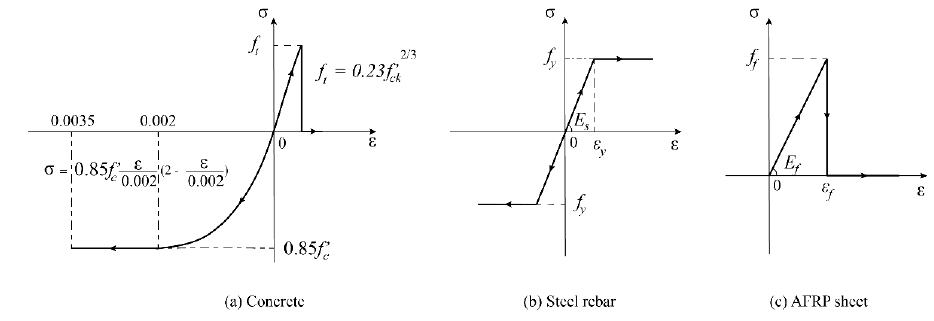
Figure 7. Stress – strain relation of each material. A cross-section of the beam was separated into horizontal layers within 5 mm thick- nesses corresponding to either concrete or reinforcements, as illustrated in Figure 8, to correctly evaluate the relationship between the curvature and bending moment for each strain level. Based on the pre-analysis data, the thickness of each layer was established. By gradually adjusting the lower strain and taking the resultant force equilibrium of all layers, the neutral axis and lower fiber strain corresponding to the arbitrary upper fiber strain of the cross-section were obtained. The associated curvature and sectional bending moment can be calculated using these upper and lower fiber strains. The upper fiber com- pression strain of the concrete might be computed by repeating the previous techniques from zero to the ultimate state ( ɛ cu = 0.35%) for these relationships. As a result, for each loading step, the curve distribution of the beam along the span corresponded to the bend- ing moment diagram. Finally, the midspan deflection was determined by calculating the